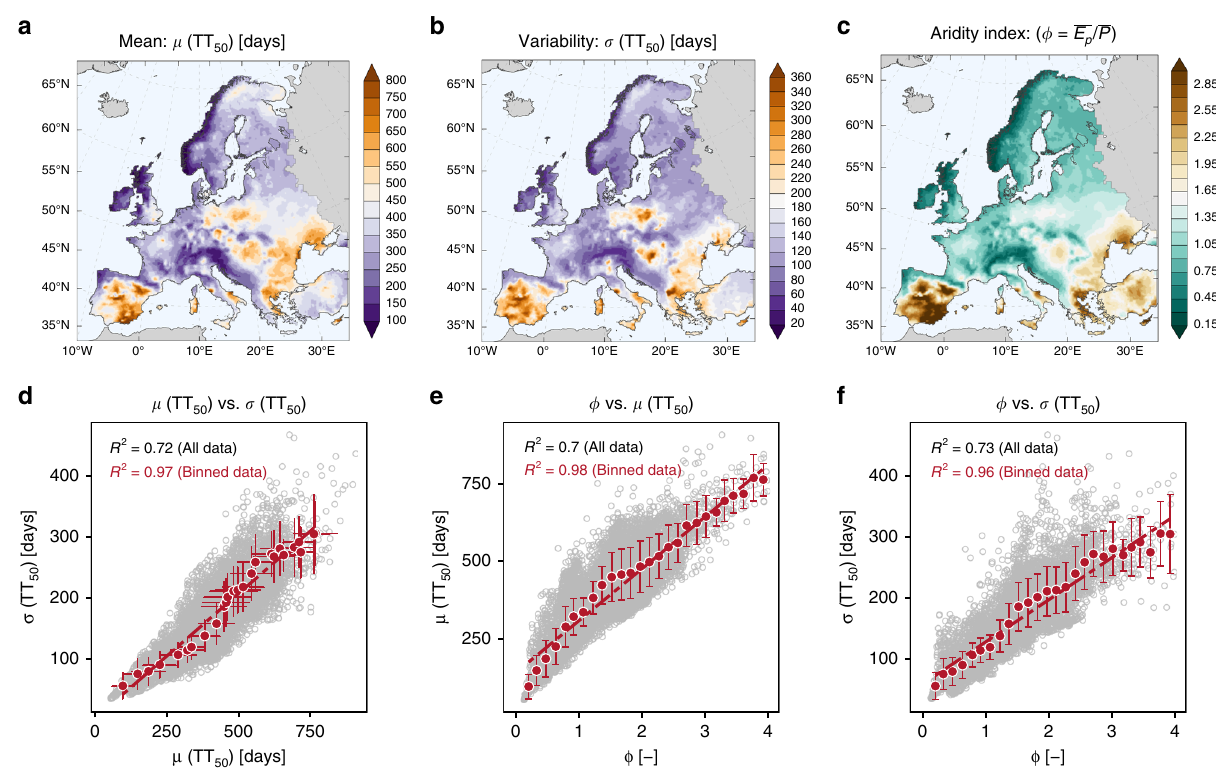
Fig. 2 Synthesis of the hydrologic transport time dynamics across Europe. The transient feature of the daily median travel times (TT 50 ; blue lines in Fig. 1d, e, f) is summarized as their temporal mean, μ (TT 50 ) and standard deviation, σ (TT 50 ) ( a , b ) for the period 1985 – 2015. The strong spatial correspondence between μ (TT 50 ) and σ (TT 50 ) is evident through the point-wise correlation analysis ( d ). The prevailing hydroclimatic feature in the form of aridity index, ϕ in ( c ), the ratio between the mean potential evapotranspiration ( E p ) and mean precipitation ( P ), is identi fi ed as the dominant factor controlling the spatial heterogeneity of the transient transport characteristics as μ (TT 50 ) and σ (TT 50 ) simulated across Europe ( e , f ). On each of the scatter plots, along with point-wise cloud data, there is also the corresponding bin estimates given as the mean and one standard deviation values of grouped data for every ϕ interval of 0.15. Binning is performed with the aim of seeking generalized relationships (i.e., after reducing the noise in scatter due to outliers) and speci fi cally in ( e , f ) to depict the role of secondary (landscape-related) factors through the representation of the binned standard deviation estimates that are relatively stable and present across the whole range of ϕ